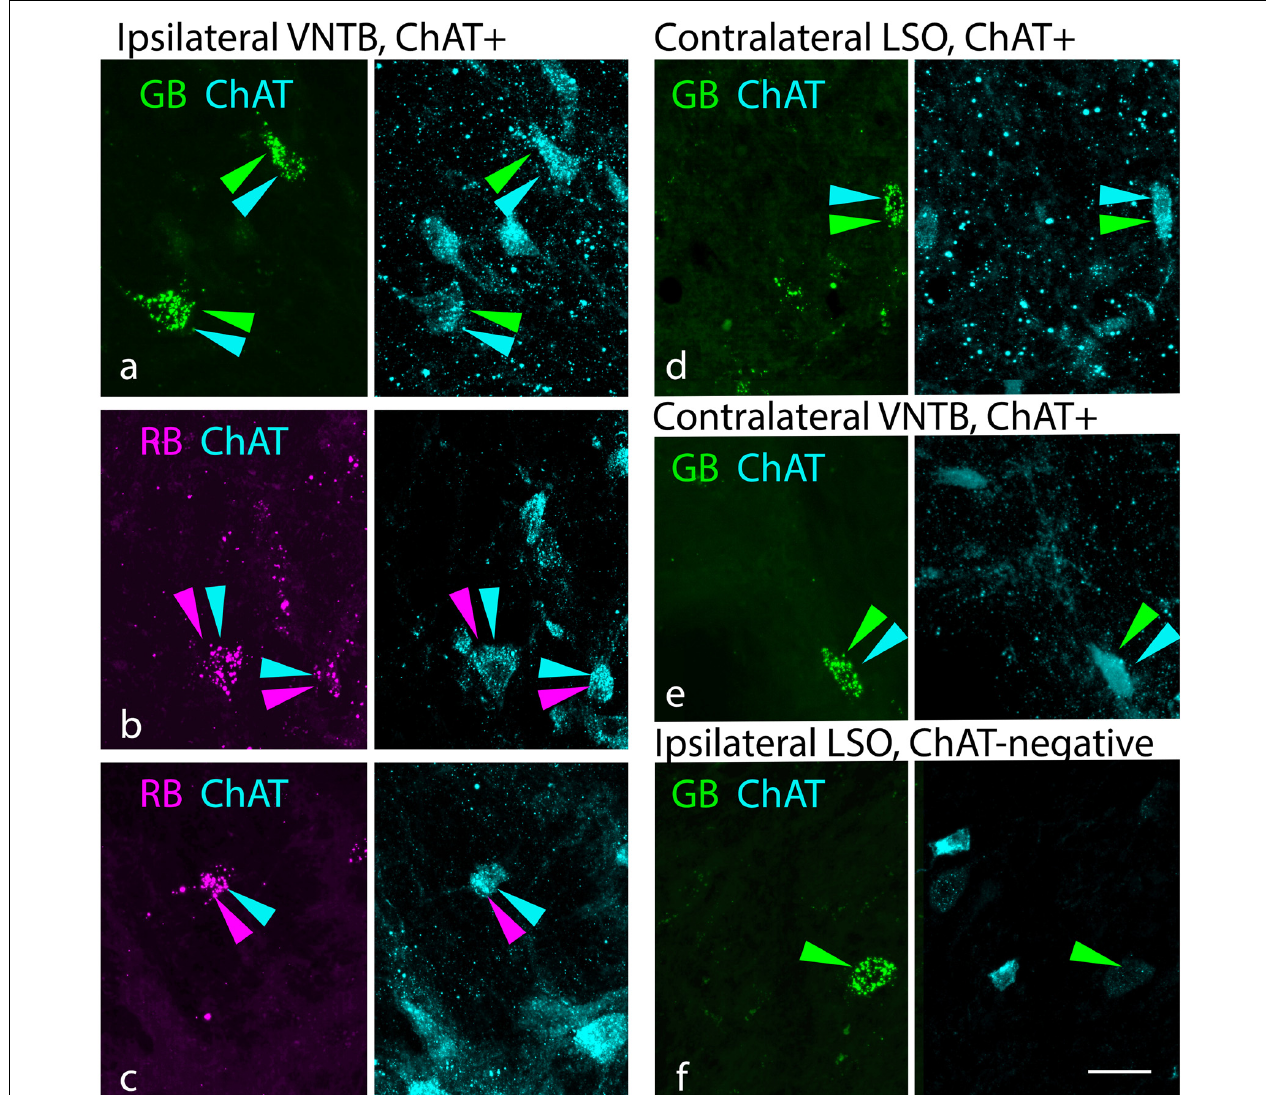
FIGURE 4 | Cholinergic and non-cholinergic SOC cells were labeled by retrograde transport from the SOC. (A–C) Examples of ChAT+ tracer-labeled cells in the VNTB ipsilateral to the tracer deposit. Paired photographs show tracer-labeled cells (magenta or green, left panel) and ChAT immunostain (cyan, right panel), demonstrating that the tracer-labeled cells could be ChAT-immunopositive. Examples included cells labeled with green beads (GB) or red beads (RB). (D,E) Examples of ChAT+ tracer-labeled cells in the contralateral lateral superior olivary nucleus [LSO, panel (D) or contralateral VNTB (panel E )]. (F) Example of a GB-labeled ChAT-negative neuron in the LSO ipsilateral to a tracer deposit. LSO, lateral superior olivary nucleus; VNTB, ventral nucleus of the trapezoid body. Panels ( A,E, and F ) are from deposit G18-2012 GB (medial SOC deposit), panel (B) is from deposit G18-2011 RB (medial SOC deposit), and panels (C) and (D) are from G18-3033 (lateral SOC deposits). Scale bar = 20 µ